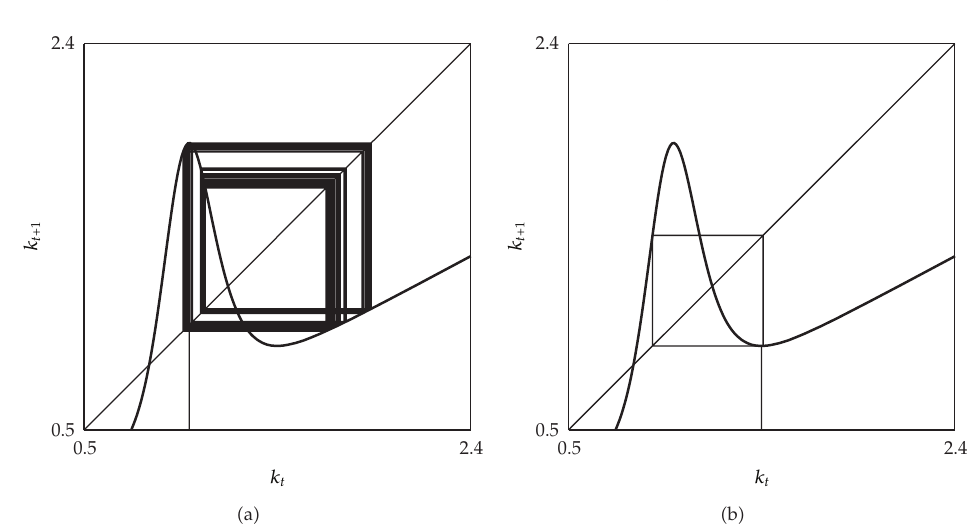
Figure 4: Coexisting attractors of F for the parameter values considered in Figure 3 and p (cid:7) 12. (cid:3) a (cid:6) 4-pieces chaotic attractor for the initial condition k M ; (cid:3) b (cid:6) cycle-2 for the initial condition k m .